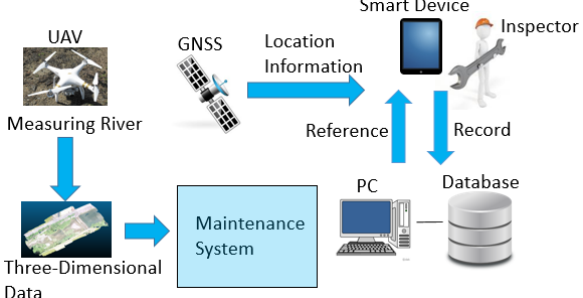
Figure 8. System architecture